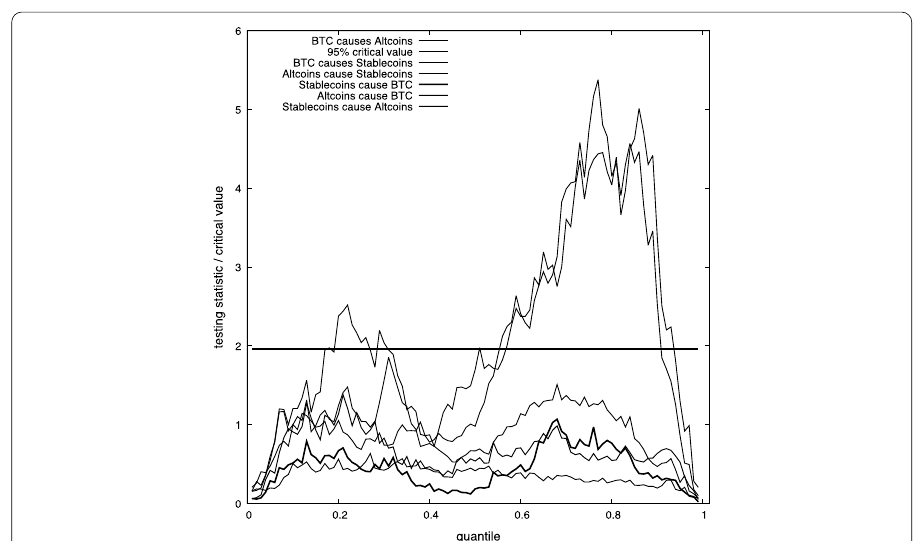
Fig. 3 Quantile-dependent Granger causality on market capitalizations. Testing statistics for all pairs are showed with a critical value for the null hypothesis of no causality from the first variable to the second one, with quantile specifics connected to the former. As the testing statistic is asymptotically normally distributed, the critical value is simply the 95th percentile of the standard Gaussian distribution, i.e., approximately 1.96 (Jeong et al. 2012). If the testing statistic exceeds the critical value, causality for the given quantile is identified. The testing statistics are calculated for the range of quantiles between 0.01 and 0.99 with a step of